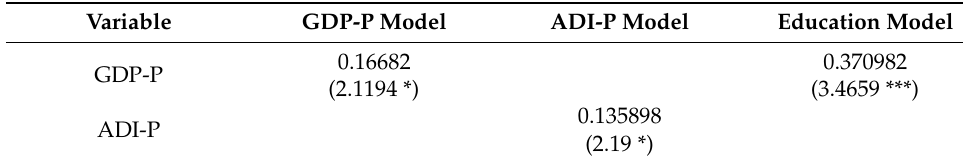
Table 5. Fixed Model results of life satisfaction and GDP-P, ADI-P and Education